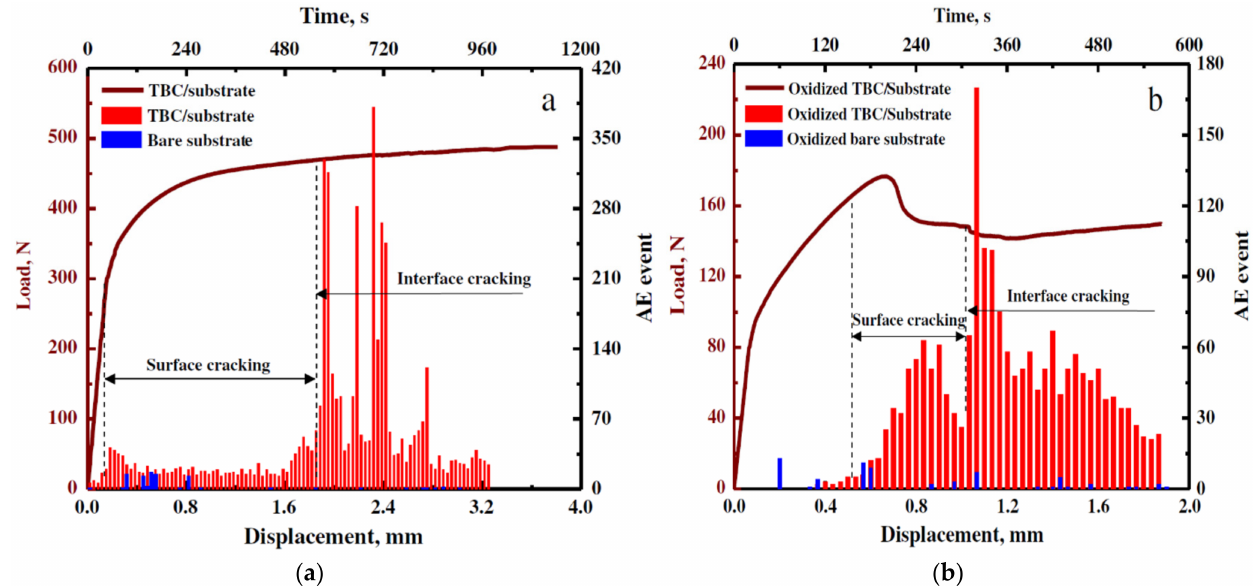
Figure 16. Load and AE event for the ( a ) as-sprayed and ( b ) pre-oxidized bare substrate and TBC/substrate